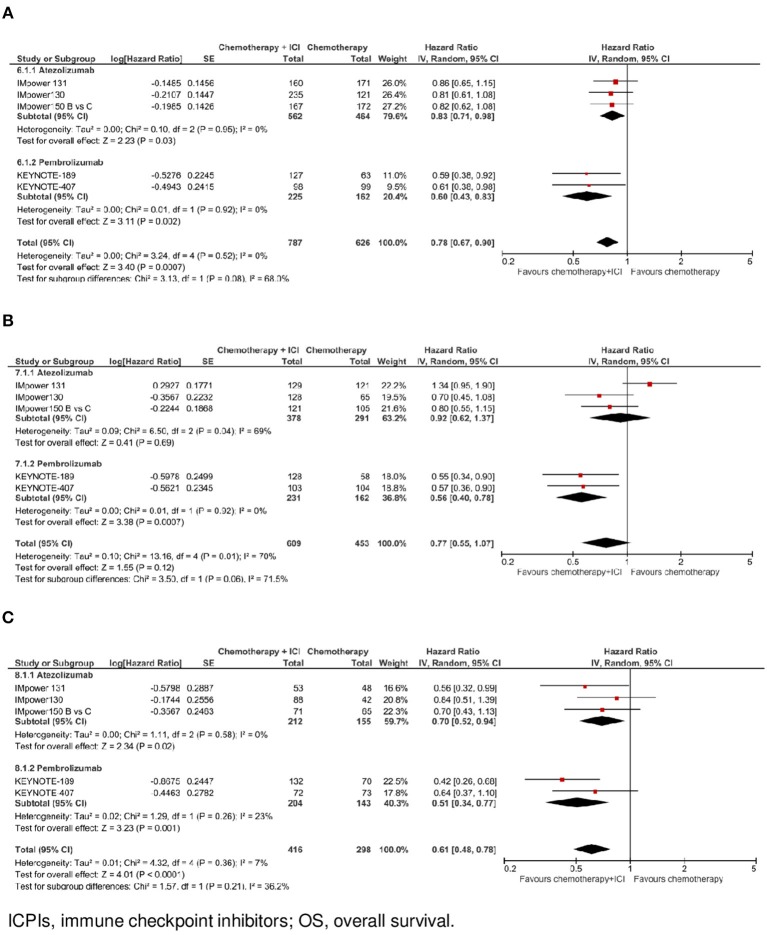
Overall survival by ICPI drug according to PD-L1 expression. (A) OS in PO-L1 negative population. (B) OS in PO-L1 low population. (C) OS in PO-L1 high population.